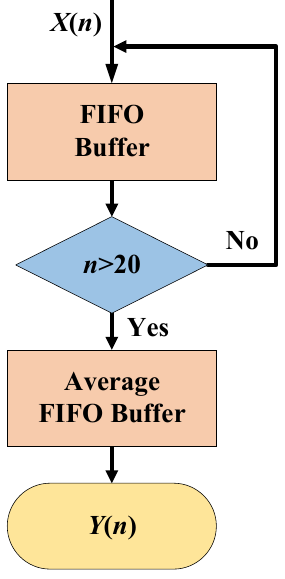
Figure 3. Moving average system flowchart.